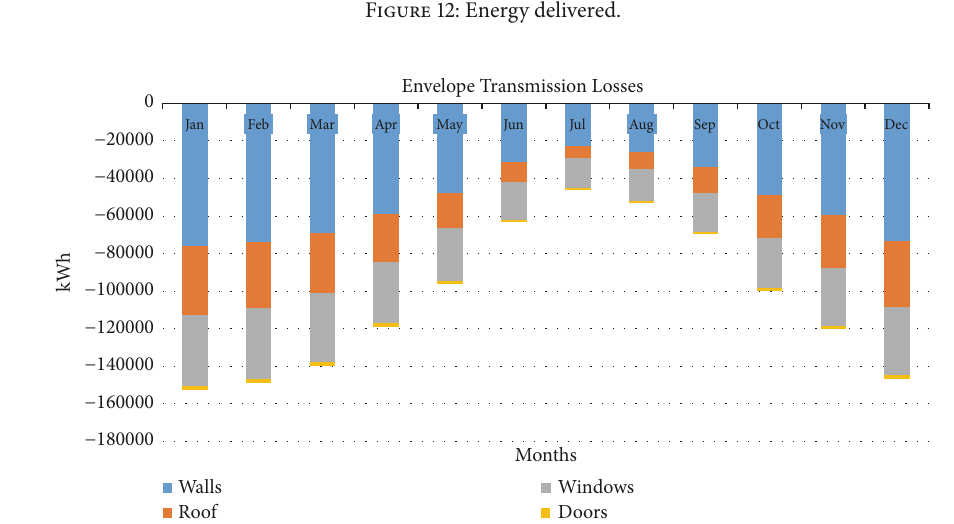
Figure 12: Energy delivered.